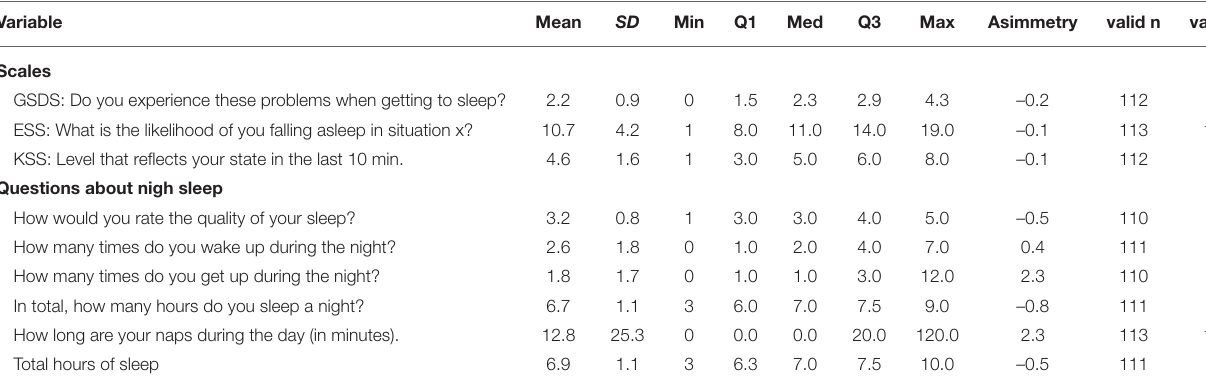
TABLE 2 | Descriptive statistics for the sleepiness variables.